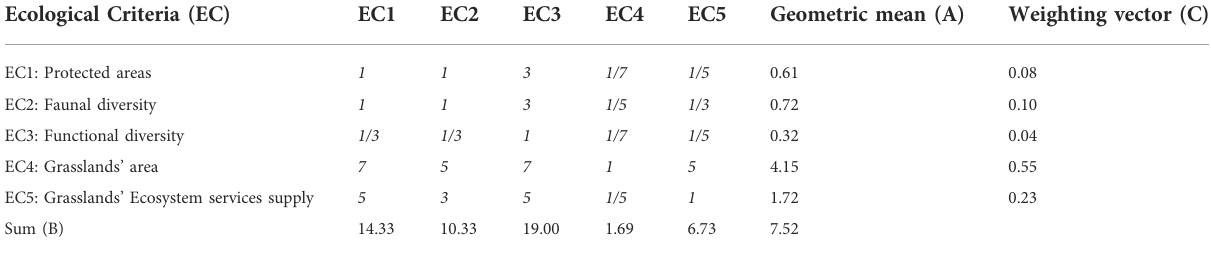
TABLE 1 Example of pairwise criteria comparison and obtaining the weighting vector corresponding to the ecological criteria. The row and column headings contain the criteria compared by the stakeholders using the Saaty scale in italic cells. Once the preferences had been assigned, the geometric mean was calculated for each row of the matrix and the geometric means of all the rows were summarized. The weighting value (relative importance) of each criterion was obtained by dividing its geometric mean (A) by the sum of the geometric means of all rows (7.52). These values determinetheweightingvector(C),whichindicatestherelativeimportanceofeachcriterion.Thelastrow(B)isusedtocalculatetheconsistency level of the matrix. Ecological Criteria